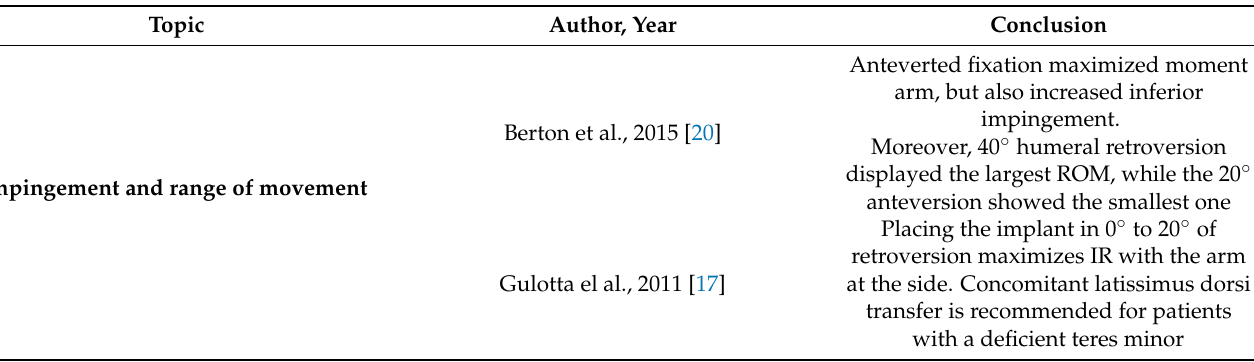
Table 2. Article conclusions on each